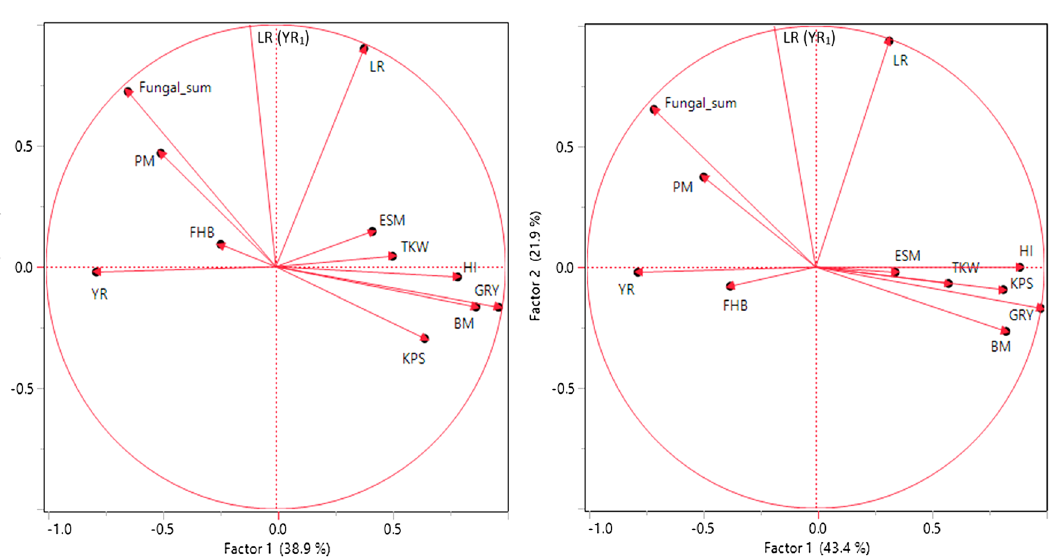
and YR (110 kg N ha −1 : − 0.11% a −1 , 220 kg N ha −1 : − 0.13% a −1 ) was notably and significantly reduced. Although a decreasing slope cannot be shown for LR based on a simple bivariate analysis, it can be inferred from the partial analysis of LR. In LR (YR 1 ) the class of low YR infestation, if the competitive influence of YR is largely excluded, LR decreases considerably (110 kg N ha −1 − 0.14% a −1 not significant; 220 kg N ha −1 : − 0.18% a −1 ). Susceptibility against FHB decreased slightly (110 kg N ha −1 : − 0.008% a −1 , not significant; 220 kg N ha −1 − 0.012% a −1 ). Breeding success in terms of healthier cultivars is also indicated by the best cultivars and their respective year of release (c.f. Supplementary Table S3 and S4). The healthiest cultivars against all fungal diseases (fungal sum) in the panel at both N levels were ‘SY Ferry’ (released 2012), ‘Xanthippe’ (2011), and ‘Zappa’ (2009). The cultivars with the lowest mean YR infestation at 110 kg N ha −1 were ‘Desamo’ (2013), ‘Nelson’ (2011) and ‘SY Ferry’ (2012) while ‘Zappa’ (2009), ‘Torrild’ (2005) and ‘Edgar’ (2010) were the best at 220 kg N ha −1 . ‘Capone’ (2012), ‘Xanthippe’ (2011), and ‘Hyland’ (2009) at 110 kg N ha −1 and ‘Xanthippe’ (2011), ‘Hyland’ (2009), and ‘Muskat’ (2010) at 220 kg N ha-1 showed the lowest LR infection. With regard to PM ‘Tabasco’ (2008), ‘Memory’ (2013), and ‘Anapolis’ (2013) at 110 kg N ha −1 and ‘Primus’ (2009), ‘Tabasco’ (2008), and ‘Edward’ (2013) at 220 kg N ha −1 were the best cultivars, nearly without infestation. ‘Greif’ (1989), ‘Elixer’ (2012), and ‘Chevalier’